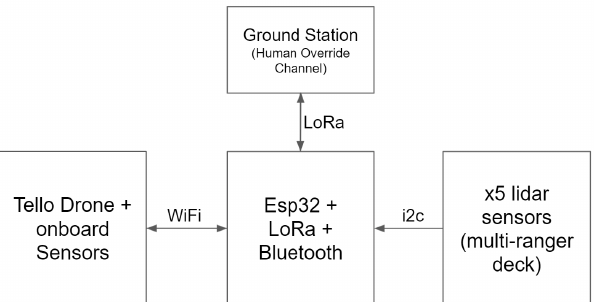
Figure 2. The communication diagram of BAT. BAT has a companion computer based on an ESP32 microcontroller which supports WiFi, Bluetooth, and LoRa. The WiFi is controlling the (original) Tello as if it was a remote control, the communication with the mapping station is performed via Long Range (LoRa), while the Bluetooth modem is reserved for short range debugging and in the future can be served as a base for drone to drone (mesh)